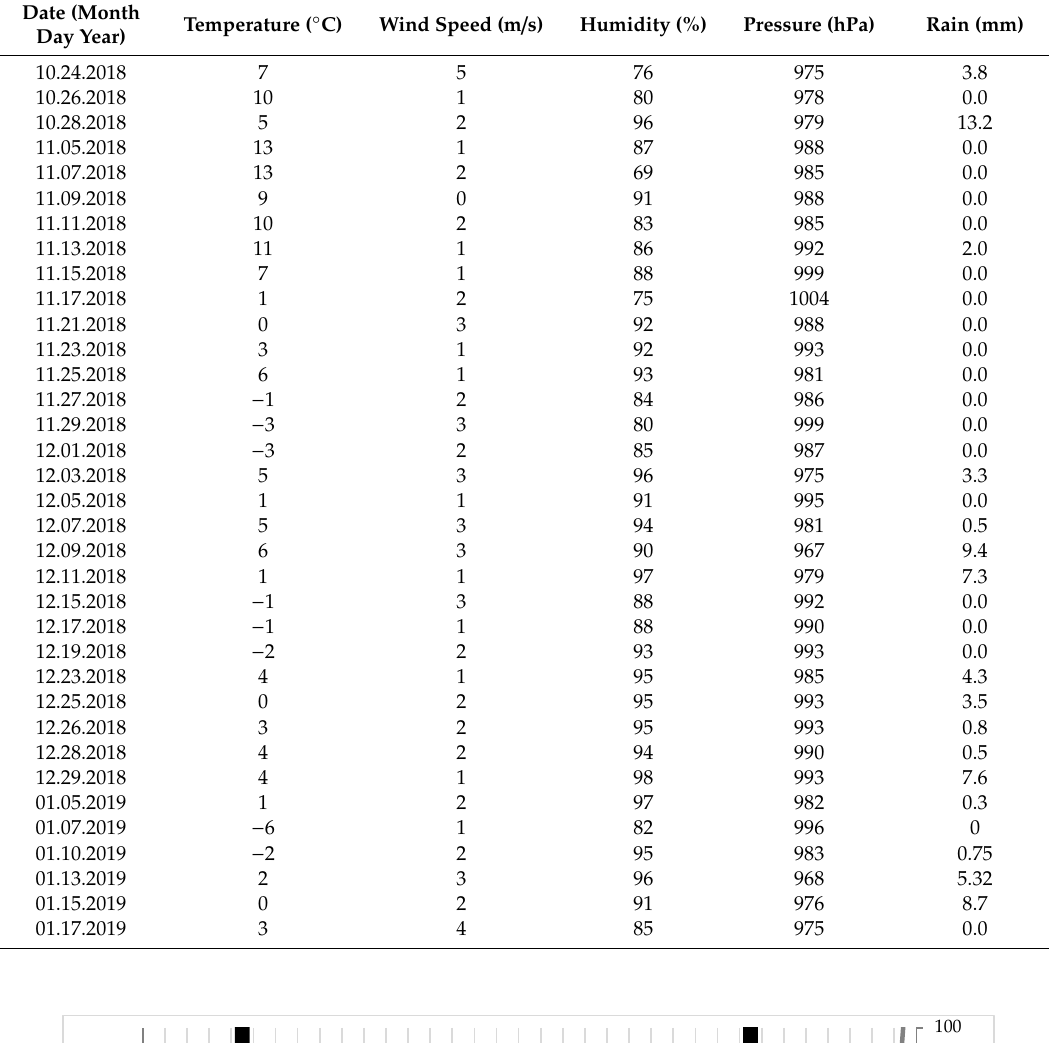
Table 2. Meteorological data (as daily average) for study site in Zabrze.